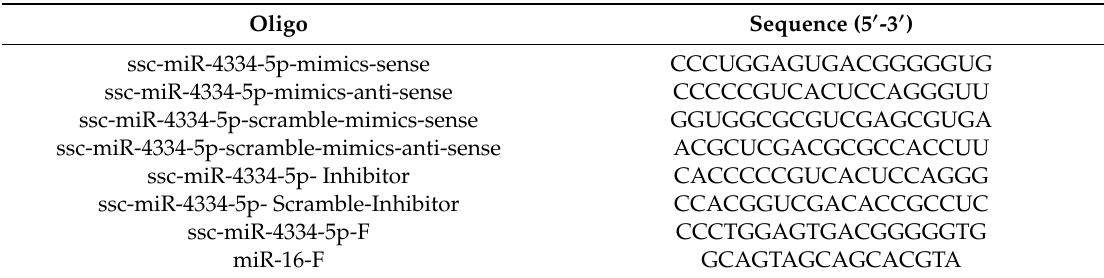
Table 1; the reverse primer is universal, which was obtained from miScript SYBR Green PCR Kit. Table 1. Oligos related to the detection of ssc-miR-4334-5p.